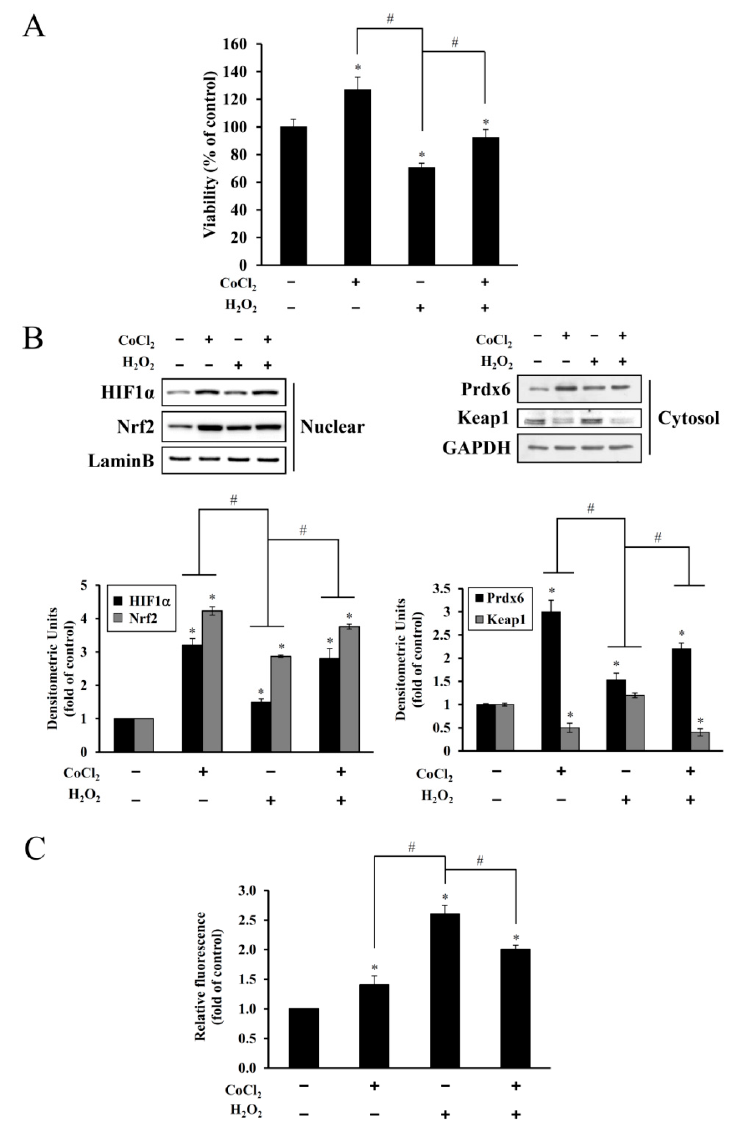
Figure 4. Protective e ff ect of CoCl 2 on H 2 O 2 -induced cytotoxicity, repression of HIF-1 α , Nrf-2, Keap1, and Prdx6 expression, and ROS accumulation. HEI-OC1 cells were preincubated with 200 µ M CoCl 2 for 6 h before exposure to 25 µ M H 2 O 2 for 9 h. ( A ) The CCK-8 assay was used to determine cell viability. Data are presented as means ± SDs for three independent experiments expressed as a percentage of the untreated control (* p < 0.05, compared with the untreated control, # p < 0.05, CoCl 2 only versus H 2 O 2 only or CoCl 2 plus H 2 O 2 ). ( B ) Representative immunoblot showing HIF-1 α , Nrf-2, Keap1, and Prdx6 expression. Individual bands were quantified densitometrically and normalized to Lamin B (HIF-1 α and Nrf-2) or GAPDH (Prdx6 and Keap1). Values in the graphs are presented as fold changes relative to the untreated control, expressed as means ± SDs of three independent experiments (* p < 0.05, compared with the untreated control, # p < 0.05, CoCl 2 only versus H 2 O 2 only or CoCl 2 plus H 2 O 2 ). ( C ) After the treatment as described above, the levels of ROS were determined by measuring CM-H 2 DCFDA. Data are presented as fold changes relative to the untreated control, expressed as ± SDs of three independent experiments (* p < 0.05, compared with the untreated control, # p < 0.05, CoCl 2 only versus H 2 O 2 only or CoCl 2 plus H 2 O 2